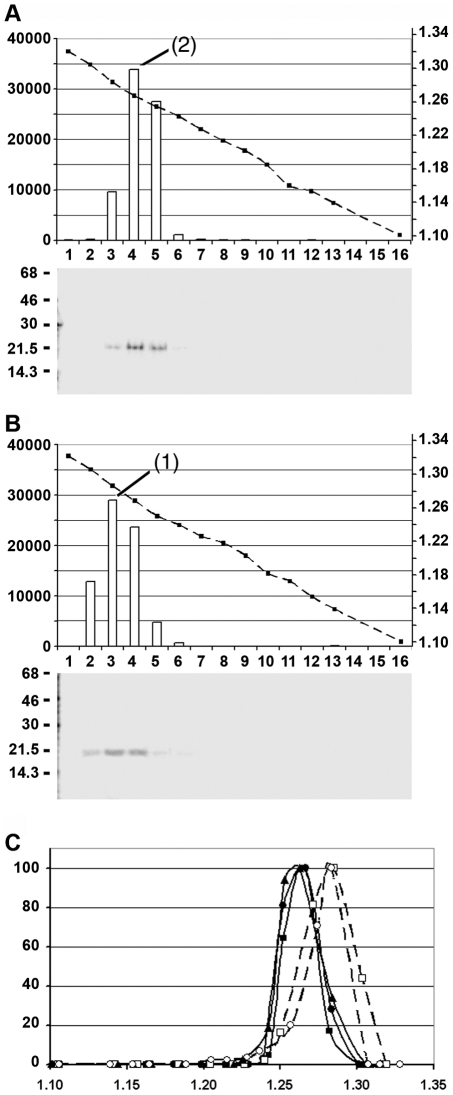
Migration of Mat-C after in vitro nuclear import.A. P-Mat-C after transport using 4×106 Digitonin-permeabilized HuH-7 cells. B. as in the upper panels but nuclear import was blocked using WGA. Centrifugation and analysis as in Fig. 2A–C. The figures show that after nuclear transport the capsids migrated with a peak density of 1.285 g/ml (1) identical to the density of P-rC (Fig. 2A. Upon inhibition of transport by WGA, the capsids exhibited a peak at 1.267 g/ml (1), showing no difference with P-Mat-C (Fig. 2B, peak (2)). C. Superposition of densities and capsid migration on Nycodenz gradients. The y axis was normalized to depict the strongest signal as 100%. X axis: density in g/ml. Bold lines: P-Mat-C (full triangles), P-Mat-C from RNase A-treated WGA-blocked cells (full squares), P-Mat-C from WGA blocked cells (full circles). Dotted lines: P-Mat-C from cells (open squares), P-rC (open circles).